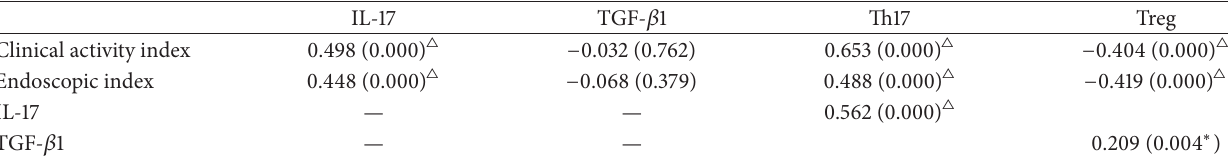
Table 3: Correlation analysis between the indexes in UC patients.